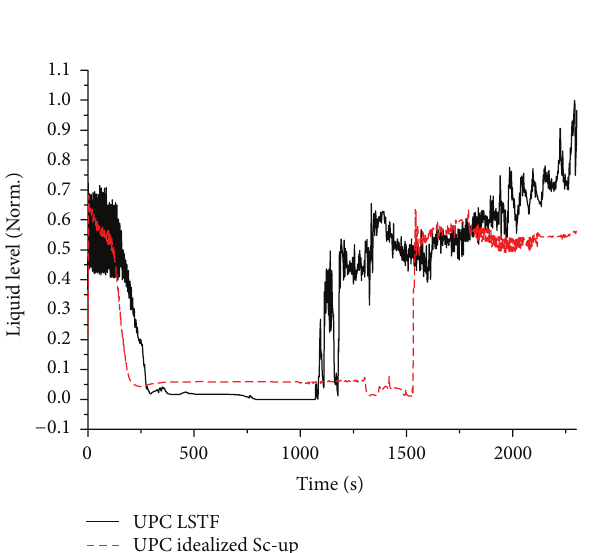
Figure 32: Core exit